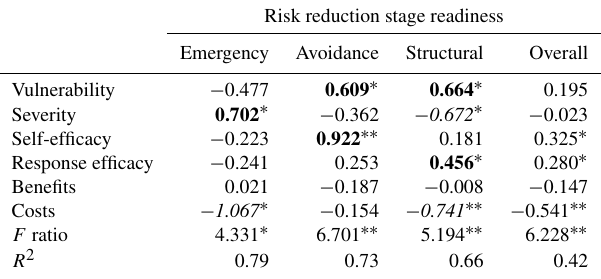
Table 2. Beta coefficients and p values for risk reduction behaviours regressed on vulnerability, severity, self-efficacy, response efficacy, benefits and